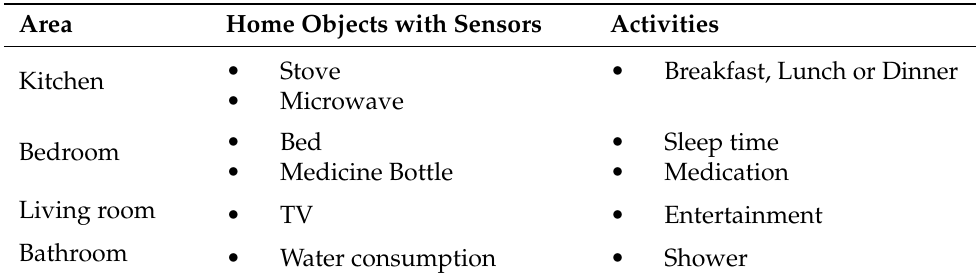
Table 1. Areas and activities to